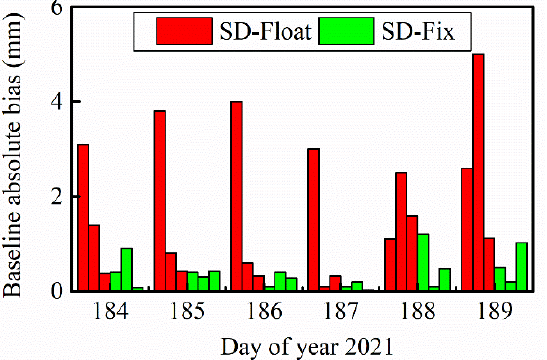
Figure 3. Bar plots showing absolute baseline biases of SD-Float and SD-Fix solutions in east, north, and up directions for 6 days.